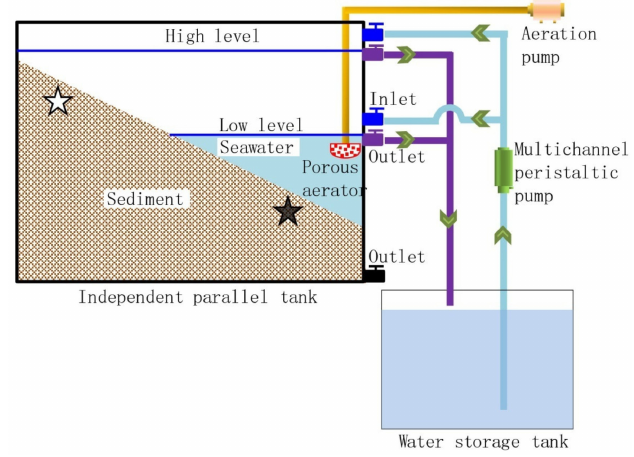
Figure 1. The lab-scale simulated intertidal system, operation process, and sampling locations. Arrows show the seawater flow direction in the system. The white star is the location of periodically submerged samples; the solid star is the location of long-term submerged